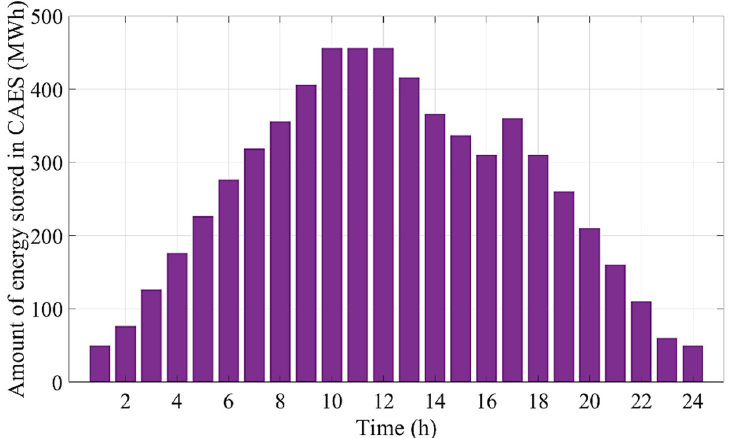
Figure 11. Quantity of energy stored in the CAES in case 4.